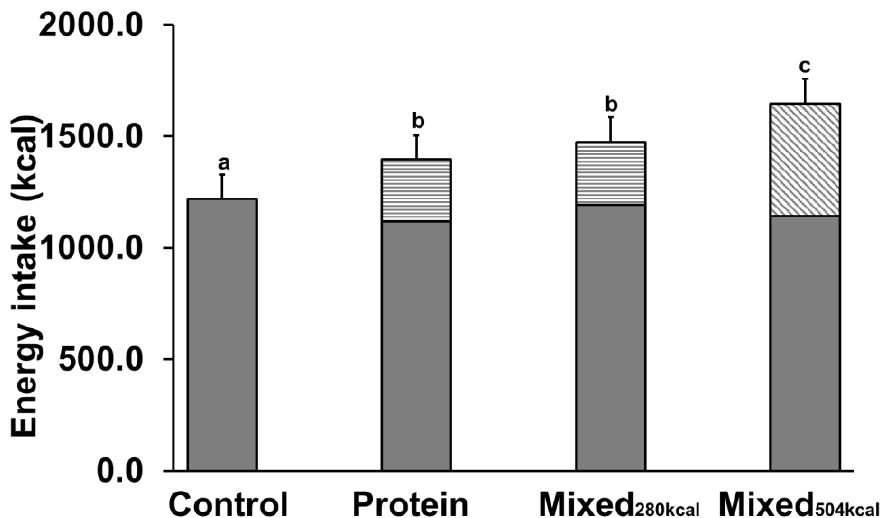
Figure 4. Energy intake ( n = 13 healthy young men) at the buffet meal (kcal; black shading) after ingestion of a control drink (450 mL; ~2 kcal/‘control’) or iso-volumetric drinks containing protein/carbohydrate/fat: (i) 14 g/28 g/12.4 g (280 kcal/‘M 280 ′); (ii) 70 g/28 g/12.4 g (504 kcal/‘M 504 ′); or (iii) 70 g/0 g/0 g (280 kcal/‘P 280 ′ - energy content of the drink as the striped part of each bar). Effects of